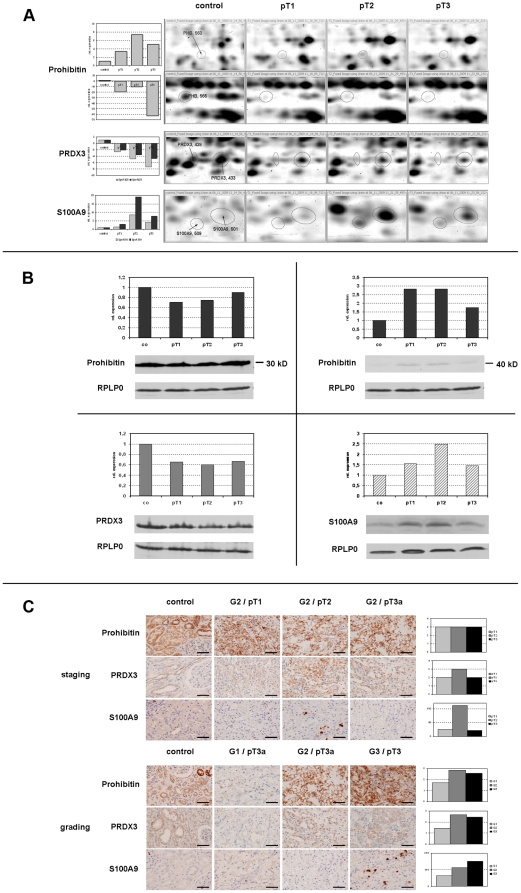
Validation of selected candidates.Prohibitin, thioredoxin-dependent peroxide reductase PRDX3 and protein S100-A9 were analyzed by immunohistochemistry. Western blotting is displayed in comparison to detailed information from the 2D-DIGE. A 2D-DIGE snapshots from fused gel images for prohibitin (30 kD and 40 kD), thioredoxin-dependent peroxide reductase PRDX3 and protein S100-A9 with quantification data (bar graph). B Protein quantification for prohibitin (30 kD and 40 kD), thioredoxin-dependent peroxide reductase PRDX3 and protein S100-A9 by Western blotting, only representative blots were shown here. RPLP0 was used as loading control. C Immunohistochemistry of staging dependencies (pT1, pT2, pT3) of G2 tumors (above). The bars represent semiquantitative quantifications of one representative sample. Immunohistochemistry depending on tumor grade (G1, G2, G3; below). The bars represents semiquantitative quantifications of different samples (7×G1, 7×G2, 8×G3).